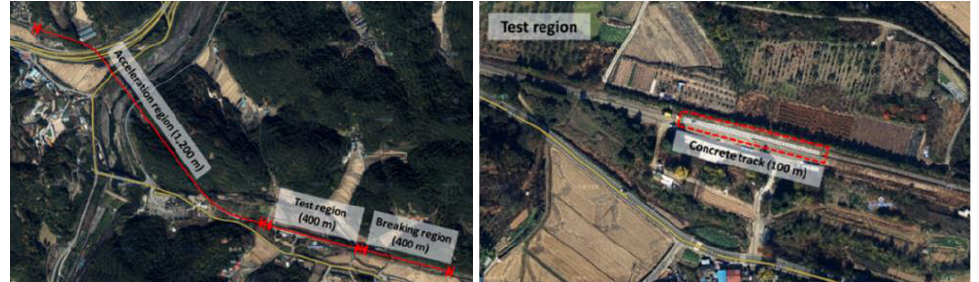
Figure 3. Real-scale test site.